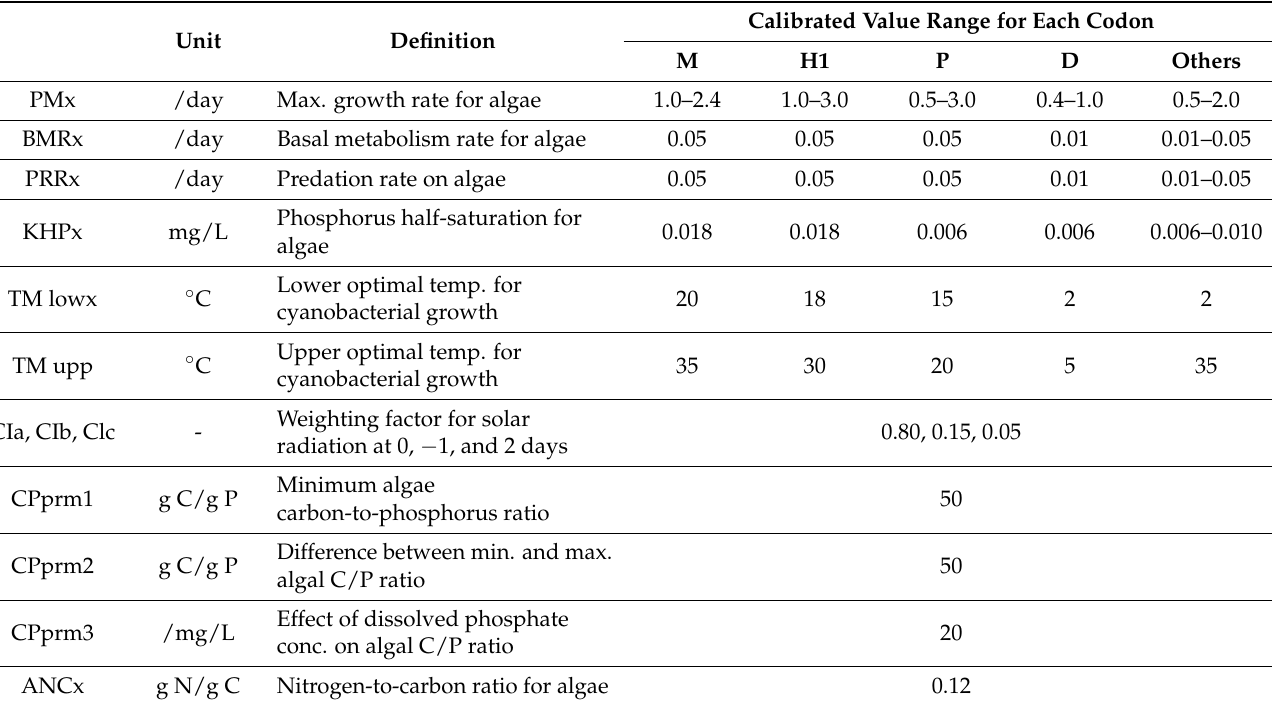
Table 7. Principal water quality calibration parameters and calibrated values in this study. EFDC model parameter.